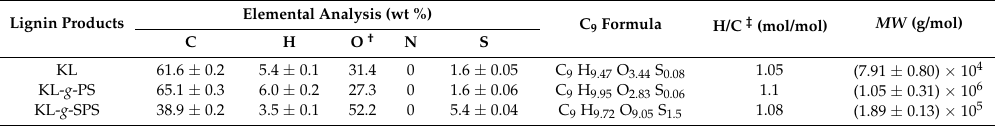
Table 2. Elemental compositions and molecular weight of KL, KL- g -PS, and KL- g